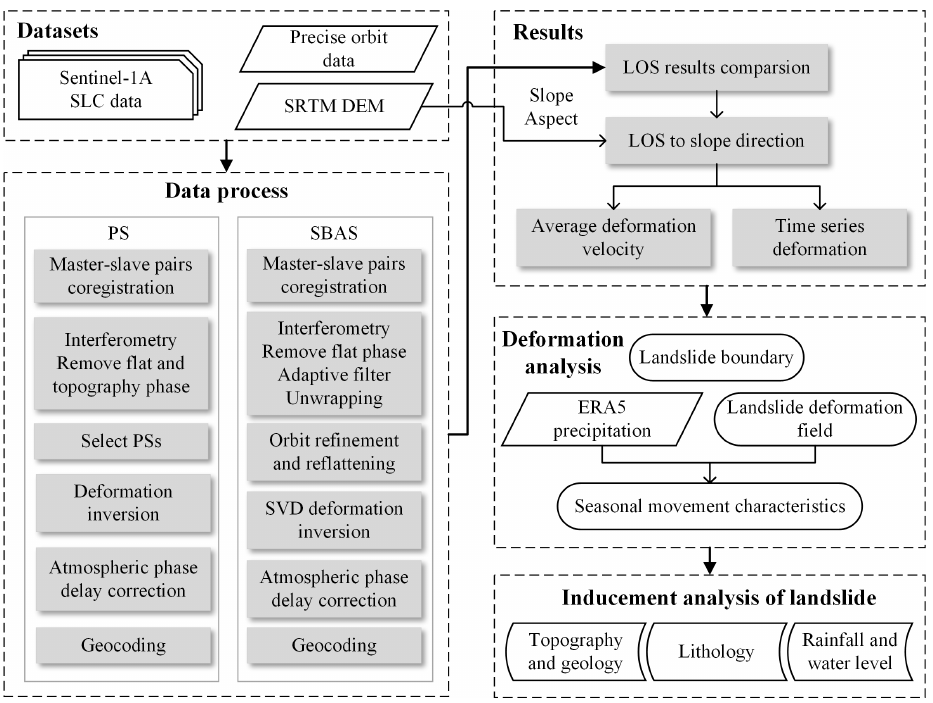
Figure 3. The workflow of the